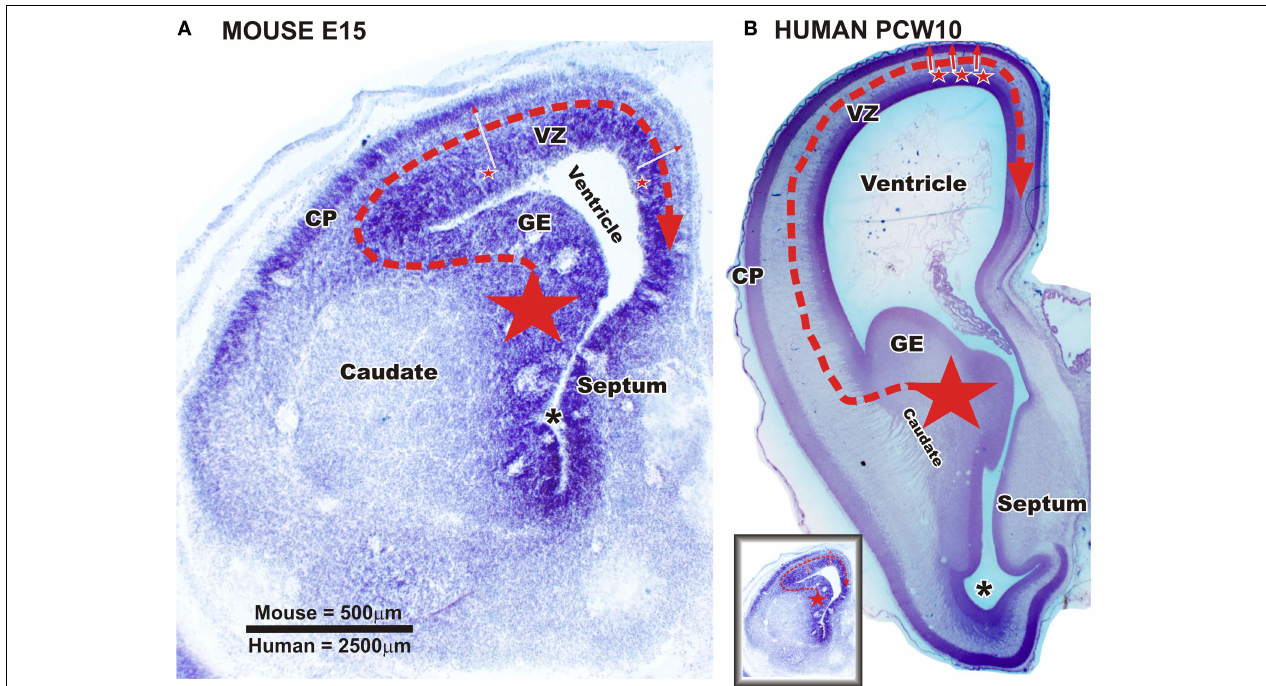
FIGURE 6 | Sources of cortical GABAergic neuron in a mouse fetus and in primate fetuses at early developmental stage (embryonic day (E) 47 to E55 in macaque/postconceptional week (PCW) 10 to PCW13 in human). Nissl staining of frontal brain sections through telencephalic vesicle at the level of septum and paleocortical ventricle (asterix) in a mouse fetus at embryonic day (E) 15 [panel (A) and in a human fetus at postconceptional week 10 panel (B) ]. (A) In the rodent, the vast majority of cortical and hippocampal GABAergic neurons are produced by ganglionic eminence (GE) (large star). The neurons migrate tangentially in the cortex (red dashed arrow). A very small percentage of the GABAergic neurons is supposed to be also